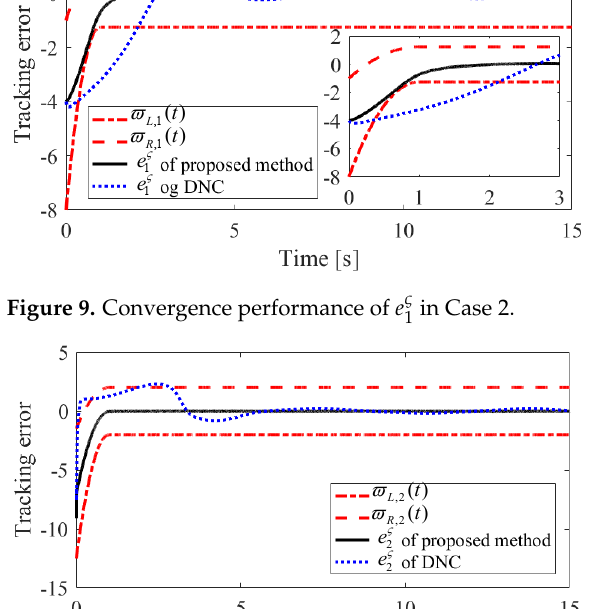
Figure 10. Convergence performance of e ς